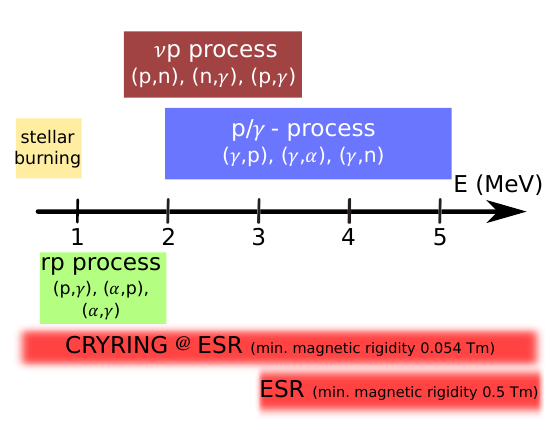
ESR (min. magnetic rigidity 0.5 Tm)